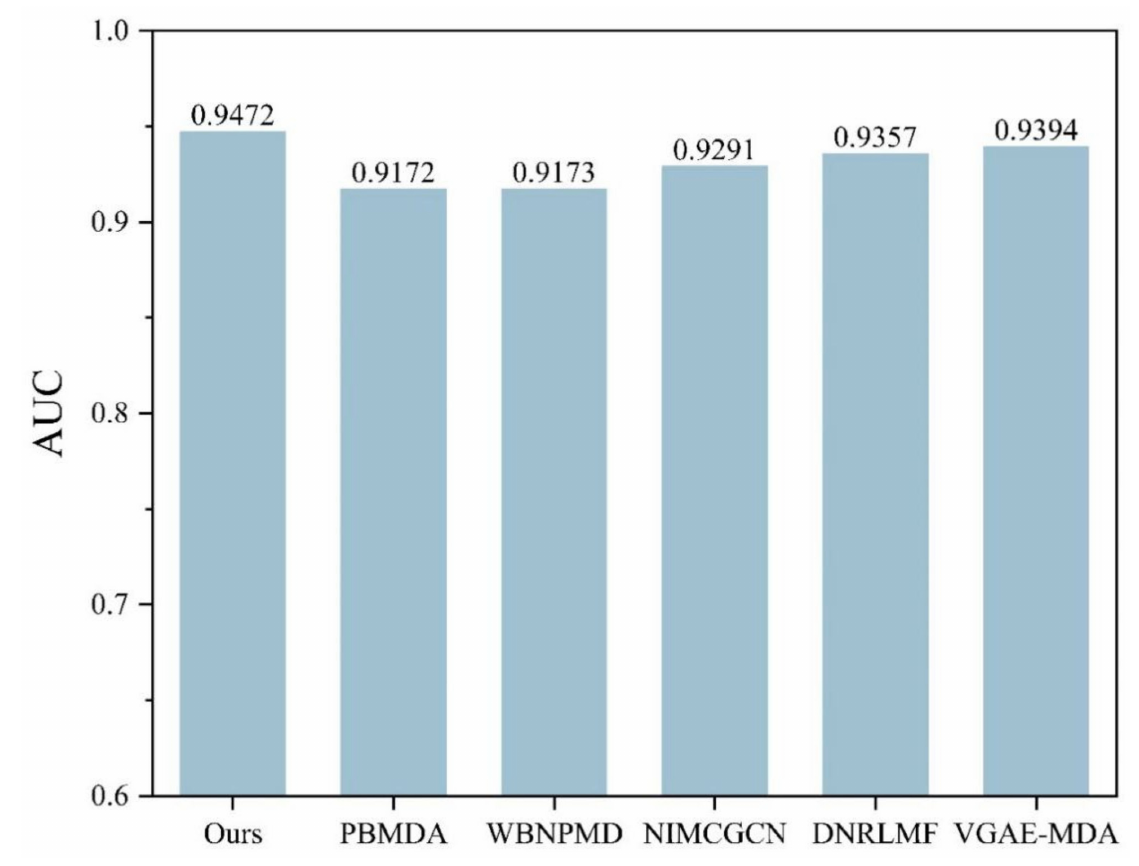
Figure 8. Performance comparison of different methods in 5-CV.